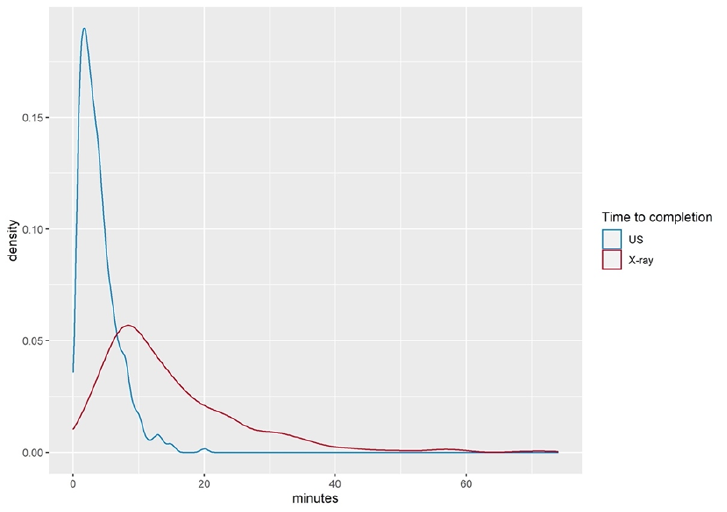
Figure 4. Time difference between ultrasound investigation and radiographic image study.